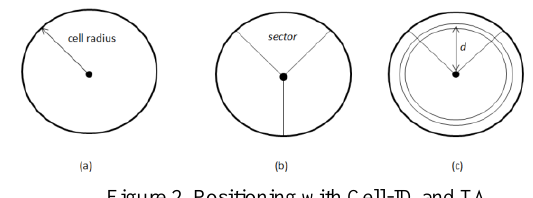
Figure 2. Positioning with Cell-ID and